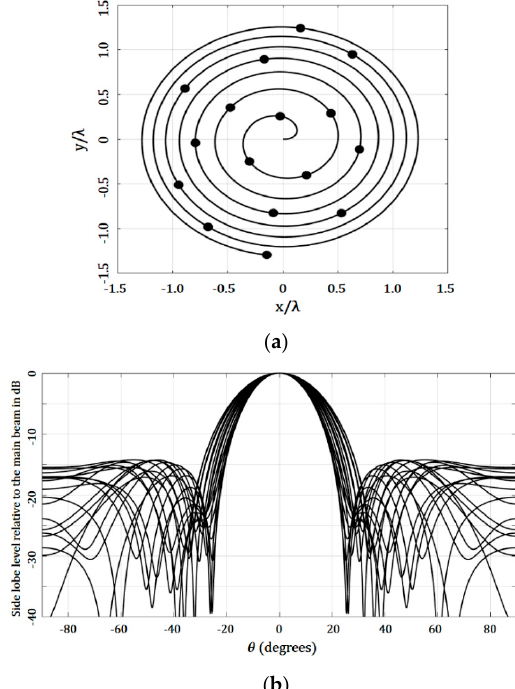
Figure 6. Results for the design case optimizing the angular separations using GA (uniform amplitude excitation): ( a ) geometry generated and ( b ) array factor. 3.2. Cases Using Non-Uniform Amplitude Excitation: Raised Cosine and Amplitude Excitations Optimized